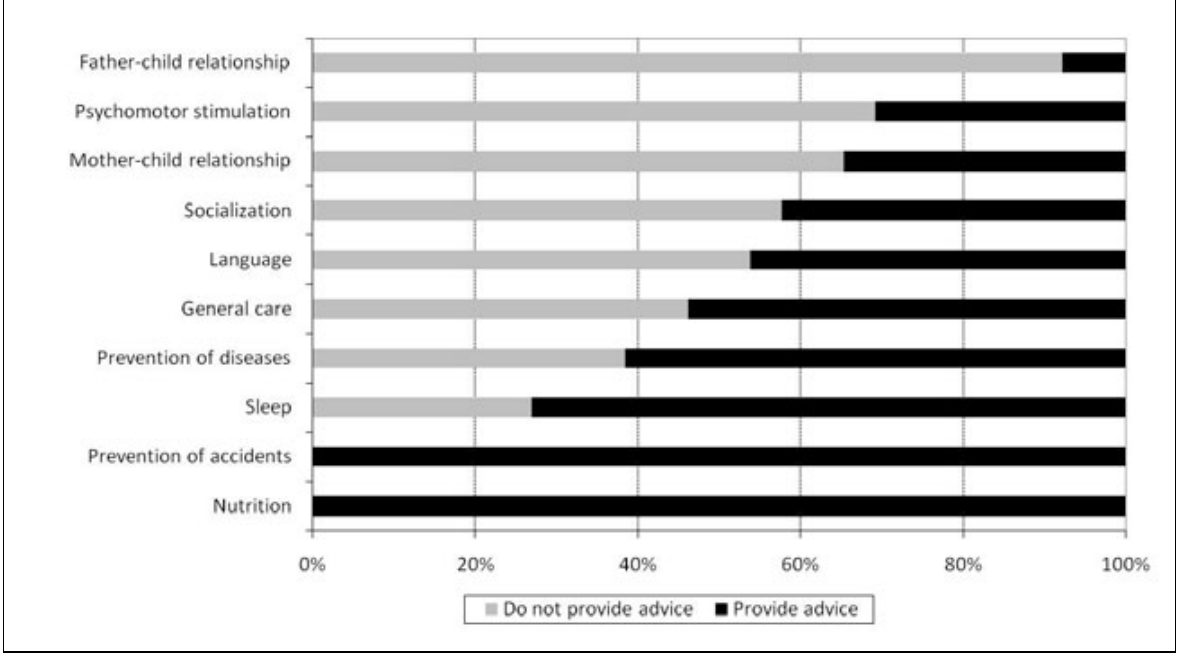
Figure 2. Percentage of pediatricians who provide advice on a given